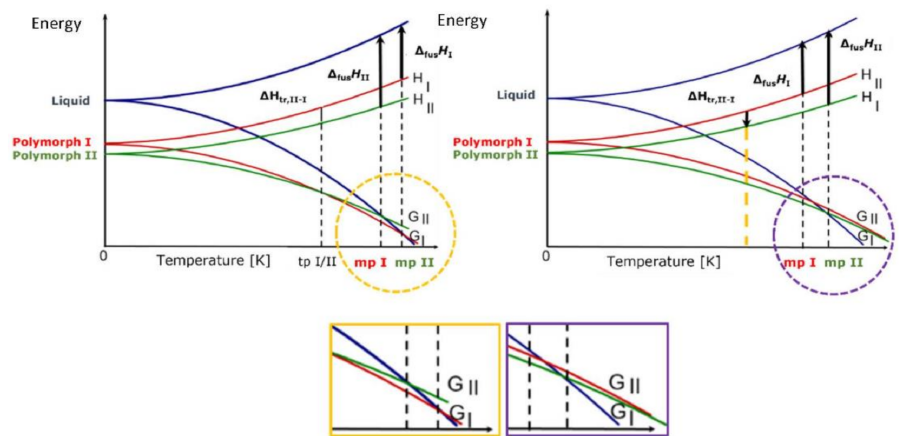
Figure 2. E/T diagrams, with G and H vs. temperature in the enantiotropic ( left ) and monotropic cases ( right